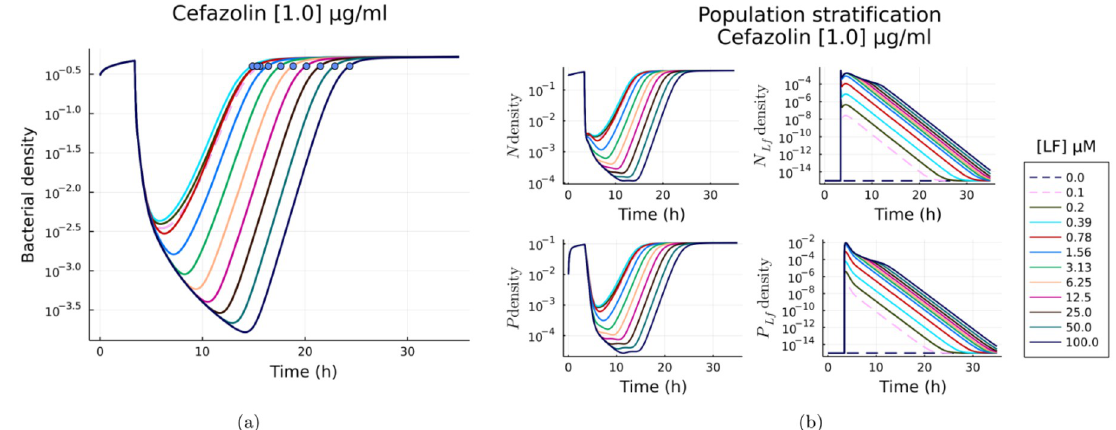
Fig 4. Model predicted population recovery profiles as a function of lactoferrin dose for 1.0 μ g/ml Cefazolin. (a) Log density of bacteria, the dots show the times at which the population reaches 50% of the carrying capacity. (b) Log densities of each subpopulation N (susceptible), N (LF bound susceptible), P (Persister), P (LF bound Lf Lf